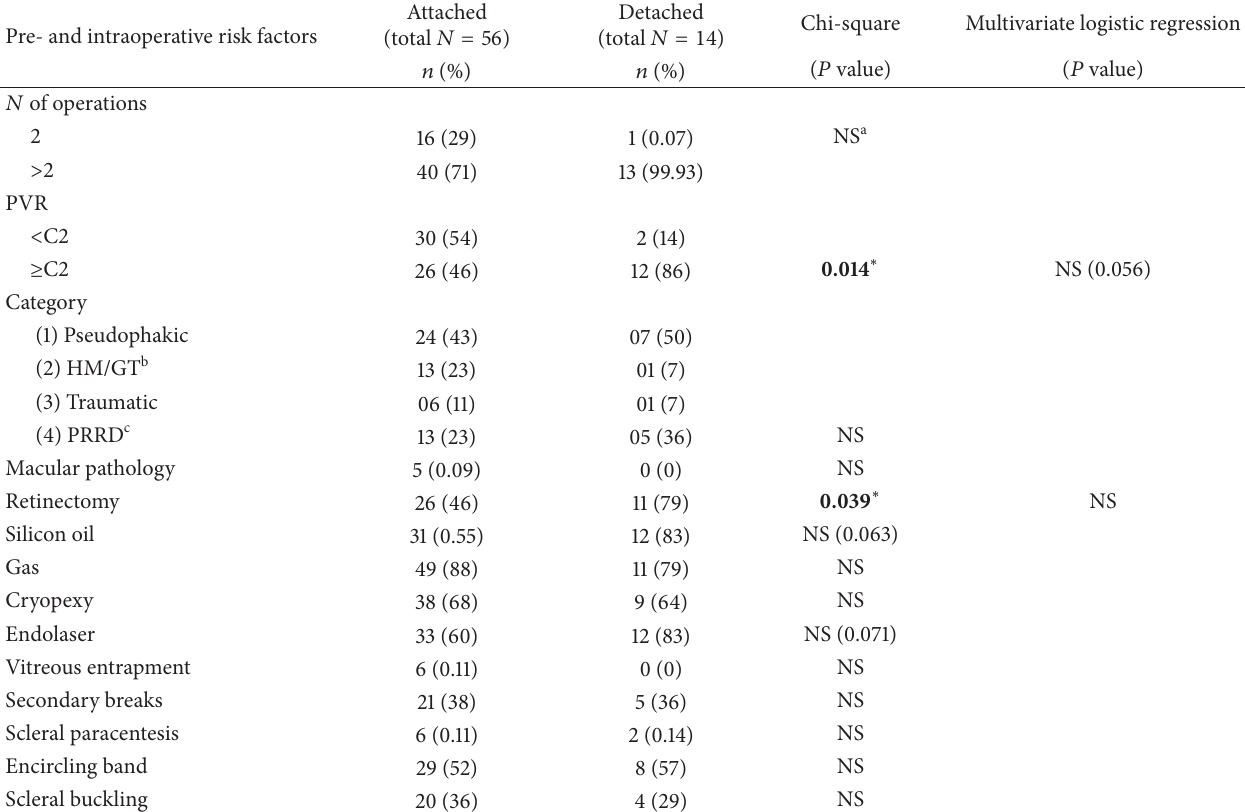
Table 2: Pre- and intraoperative factors affecting the final anatomic